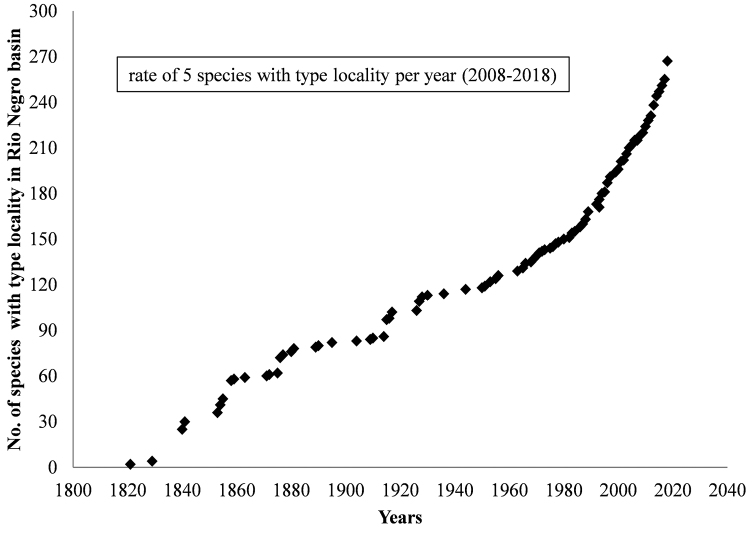
Cumulative curve of valid fish species numbers described from type localities in the Rio Negro basin between 1821 and 2019, based on the catalogs of Reis et al. (2003) and Buckup et al. (2007), and species descriptions published after those compilations.